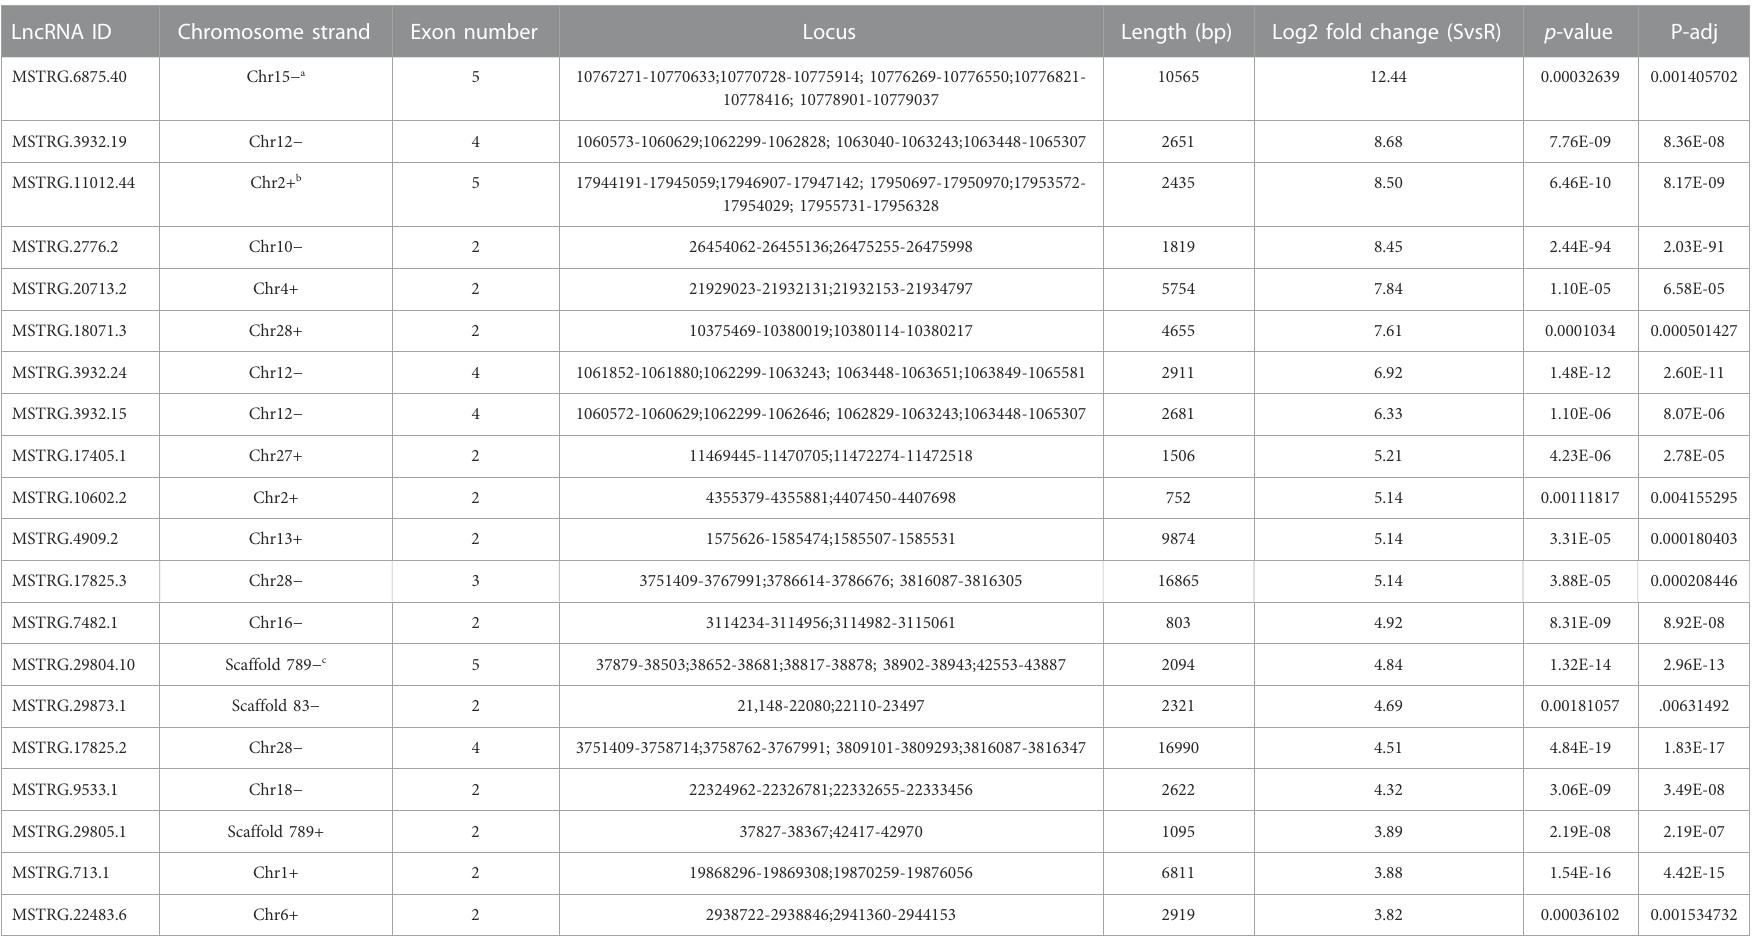
TABLE 1 Top 20 predictive lincRNAs differential highly expressed in the S